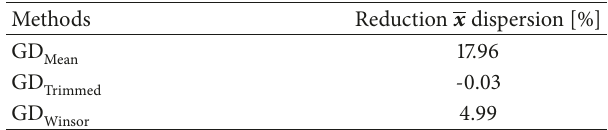
Table 15: Log-normal with 50 points.